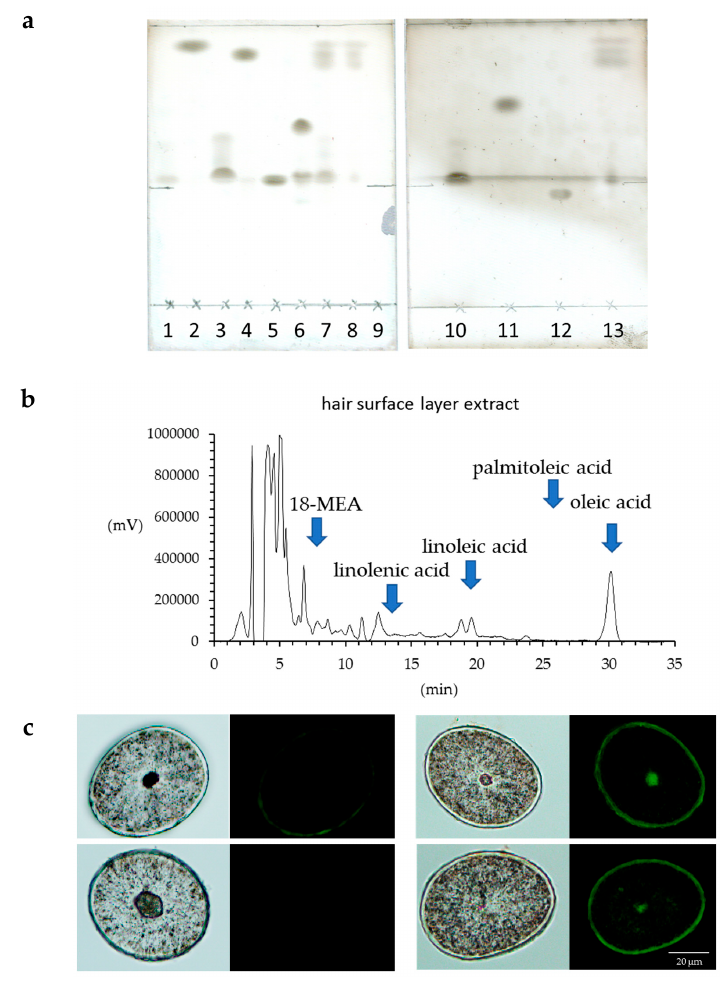
Figure 5. Analysis of human hair lipids and unsaturated fatty acids in the surface layer of hair. ( a ) TLC analysis of hair lipids extracted with acetone, hexane or xylene. Lipids in the surface layer of human hair were eluted with acetone, hexane or xylene, and these eluates were analyzed by TLC. 1, α -linolenic acid; 2, squalene; 3, oleic acid; 4, cholesteryl oleate; 5, cholesterol; 6, triolein; 7, acetone extraction of hair; 8, hexane extraction of hair; 9, control; 10, linoleic acid; 11, methyl oleate; 12, ceramide 2; 13, xylene extraction of hair. ( b ) high-performance liquid chromatography (HPLC) analysis of unsaturated fatty acids in the surface layer of hair extracted with acetone. The chart of the fluorescence intensity of 9-anthryldiazomethane (ADAM) alone was subtracted from the chart of the fluorescence intensity of the ADAM-derivatized acetone extract from the hair surface layer, and the results are presented in the form of a graph. ( c ) Localization of peroxidized lipids in the cross-section of hair exposed to UV radiation. ( left ) Bright-field images and images stained with Liperfluo of the cross-section of hair not exposed to UV radiation. ( right ) Bright-field images and images stained with Liperfluo of the cross-section of hair exposed to UV radiation.